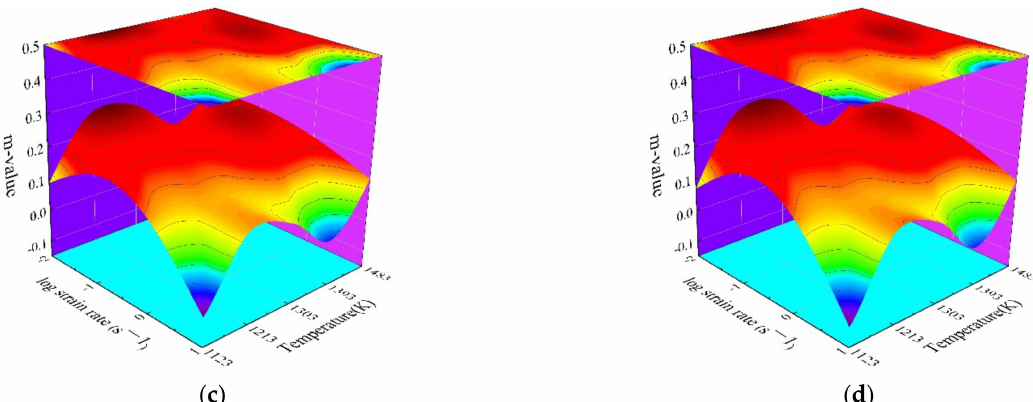
Figure 6. Strain-rate sensitivity index for SAE 5137H steel under different true strains of ( a ) 0.3, ( b ) 0.5, ( c ) 0.7, and ( d ) 0.9.